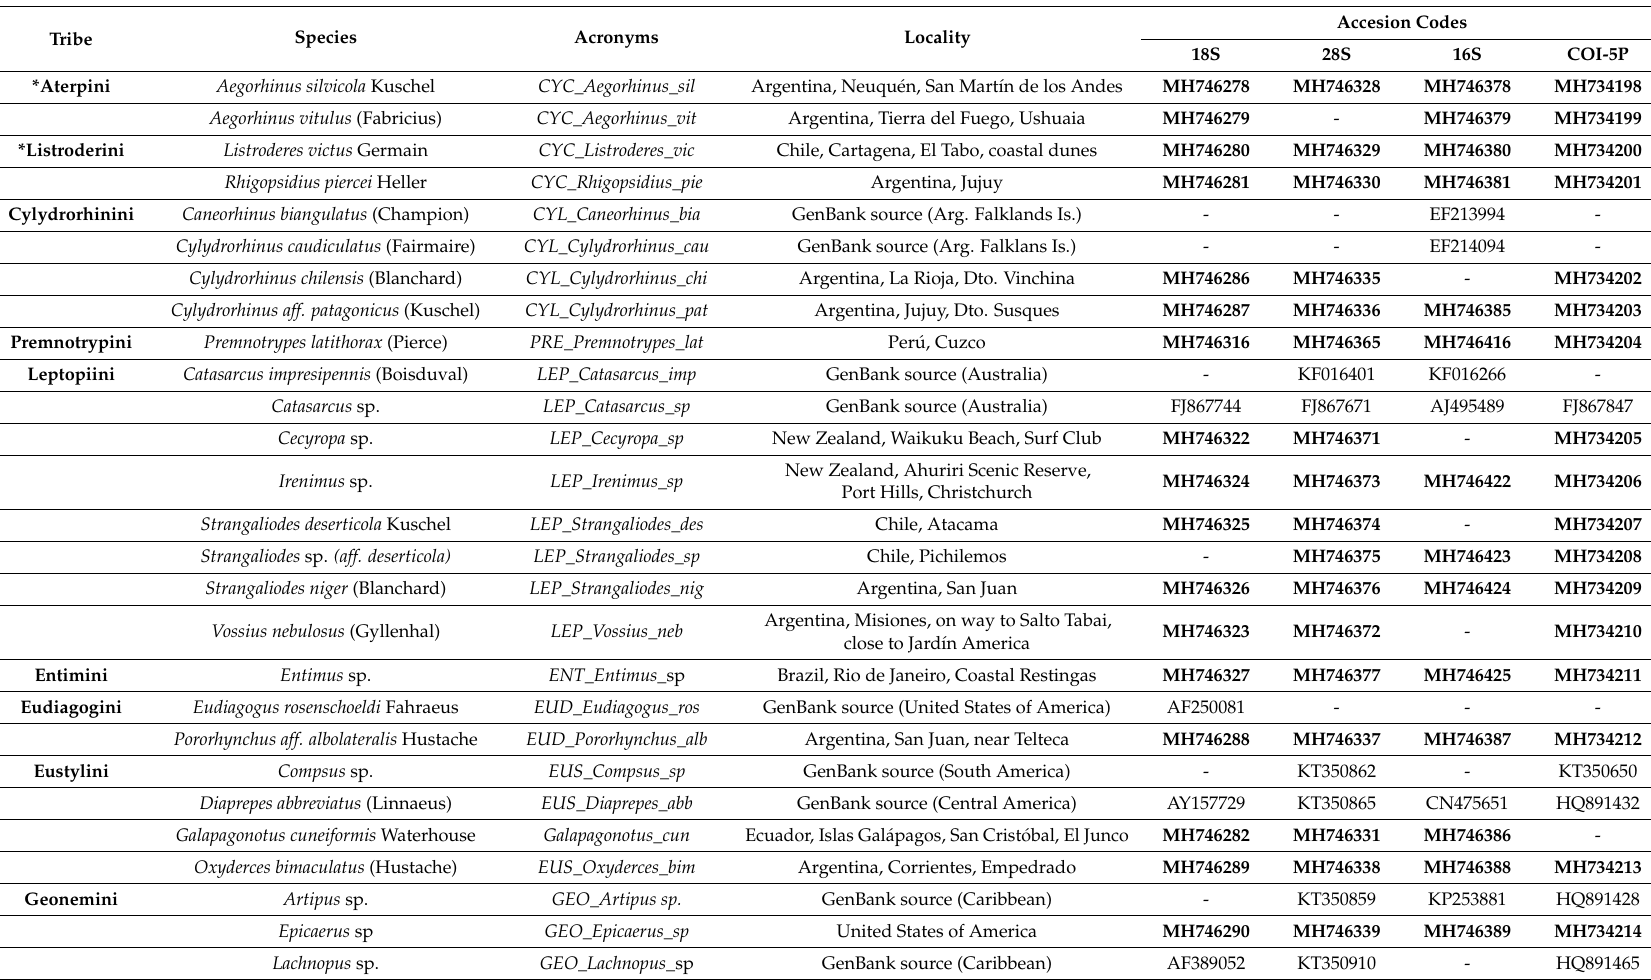
Table 1. Studied taxa, geographical sources and GenBank accession numbers. Codes in boldface indicate the new sequences produced for this study. * Tribes of Outgroups, in